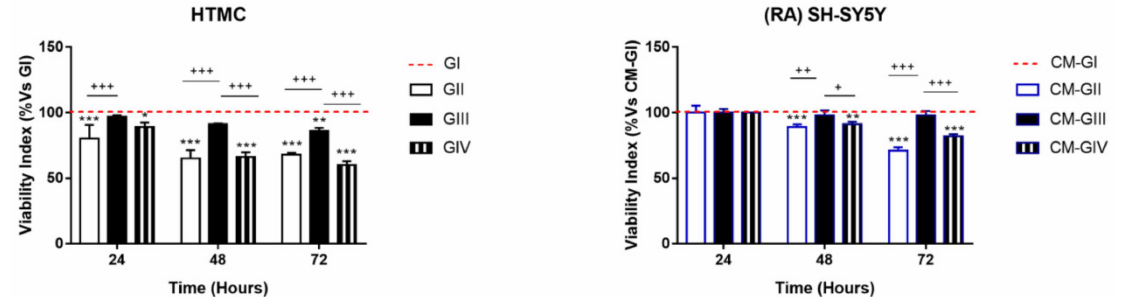
Figure 2. Alamar Blue assay. During experimental treatments, the metabolic state of HTMC and RA-SH-SY5Ywas evaluated by Alamar Blue assay. The bar diagrams show the viability indices in terms of resazurin reduction and are expressed as % of their respective control cell group. Each bar represents the mean ± S.D. of 3 separated experiments in triplicate. *** p < 0.001, ** p < 0.01, * p < 0.05 vs. control cell group; +++ p < 0.001, ++ p < 0.01, + p < 0.05 vs. treated cell groups (Two-way ANOVA followed by Bonferroni